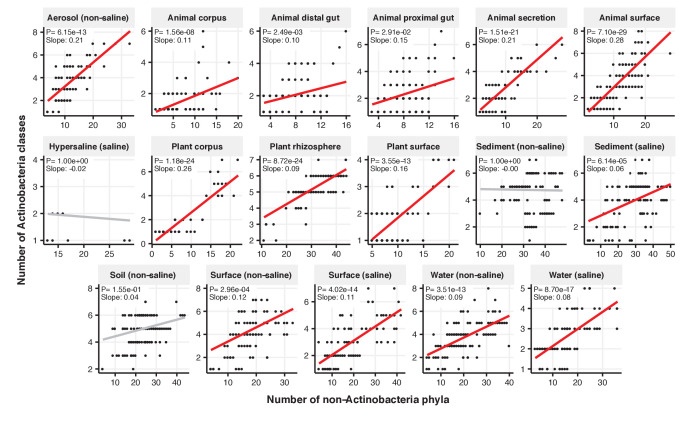
Focal-lineage diversity as a function of community diversity across biomes in Actinobacteria.Linear models are shown for the number of classes per phylum (y-axis) as a function of community diversity (number of non-focal phyla, x-axis) in each of the 17 environments (EMPO3 biomes). Only environments containing the focal lineage are shown. P-values are Bonferroni corrected for 17 tests. Significant (p<0.05) models are shown with red trend lines.